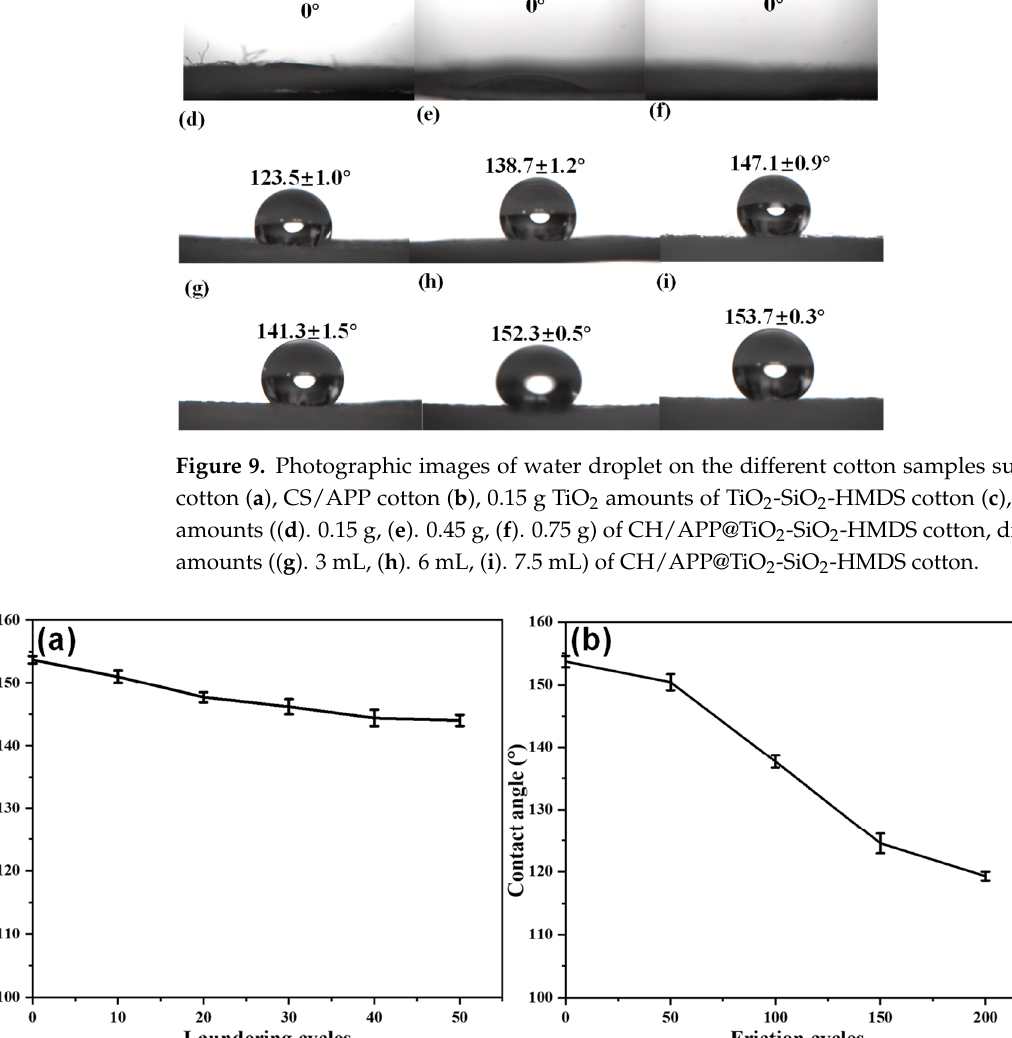
Figure 9. Photographic images of water droplet on the different cotton samples surface. Pristine cotton ( a ), CS/APP cotton ( b ), 0.15g TiO 2 amounts of TiO 2 -SiO 2 -HMDS cotton ( c ), different TiO 2 amounts ( d . 0.15g, e . 0.45g, f . 0.75g) of CH/APP@TiO 2 -SiO 2 -HMDS cotton, different HMDS amounts ( g . 3ml, h . 6ml, i . 7.5ml) of CH/APP@TiO 2 -SiO 2 -HMDS cotton.